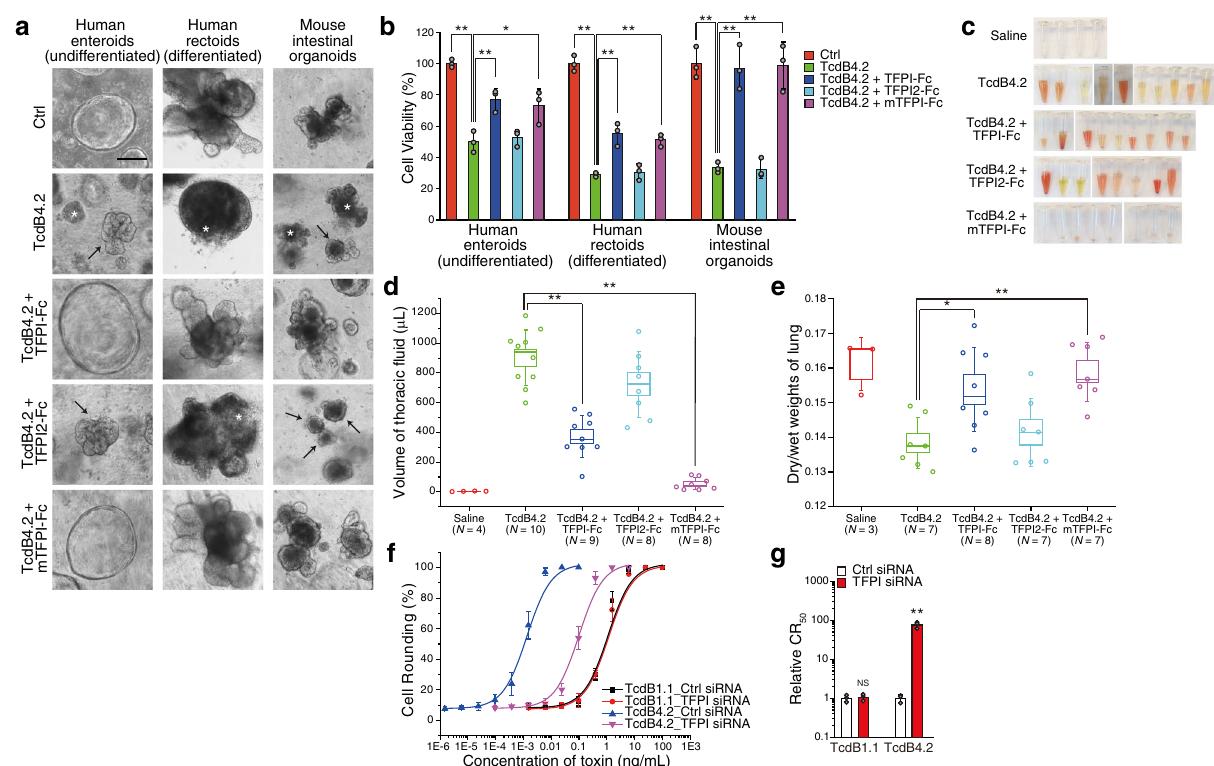
Fig. 4 | TFPI is a receptor for TcdB4.2 in intestinal organoids and lung tissues. a Cultured undifferentiated human enteroids (in growth medium), differentiated human rectoids (in differentiation medium), and mouse intestinal organoids were exposed to either TcdB4.2 alone (10 pM) or TcdB4.2 pre-incubated with Fc-tagged TFPI,TFPI2,ormTFPI(100nM)for8h.PBSwasusedascontrol(Ctrl).Starsindicate thedissociatedorganoidswithreleasedluminalcontents;arrowsindicateshrunken organoids; scale bar, 50 µ m. Representative images are from one of three inde- pendent experiments. b Experiments were carried out as described in panel ( a ). Afterexposureto toxin for3 days, cellviabilitywas measured using the MTT assay andplottedasabar-chart.Errorbarsindicate±s.d.; N =3(biologicallyindependent experiments);*, p <0.05;**, p <0.01(Student ’ s t -test,two-sided). c , d Accumulation of fl uid in the thoracic cavity occurred within 15h after intraperitoneal injection of TcdB4.2intomice(50ngper25gbodyweight).InjectionofTcdB4.2pre-incubated with Fc-tagged TFPI or mTFPI at 1:2000 molar ratios showed less fl uid accumula- tion. Co-injection of TcdB4.2 with Fc-tagged TFPI2 at 1:2000 molar ratio did not